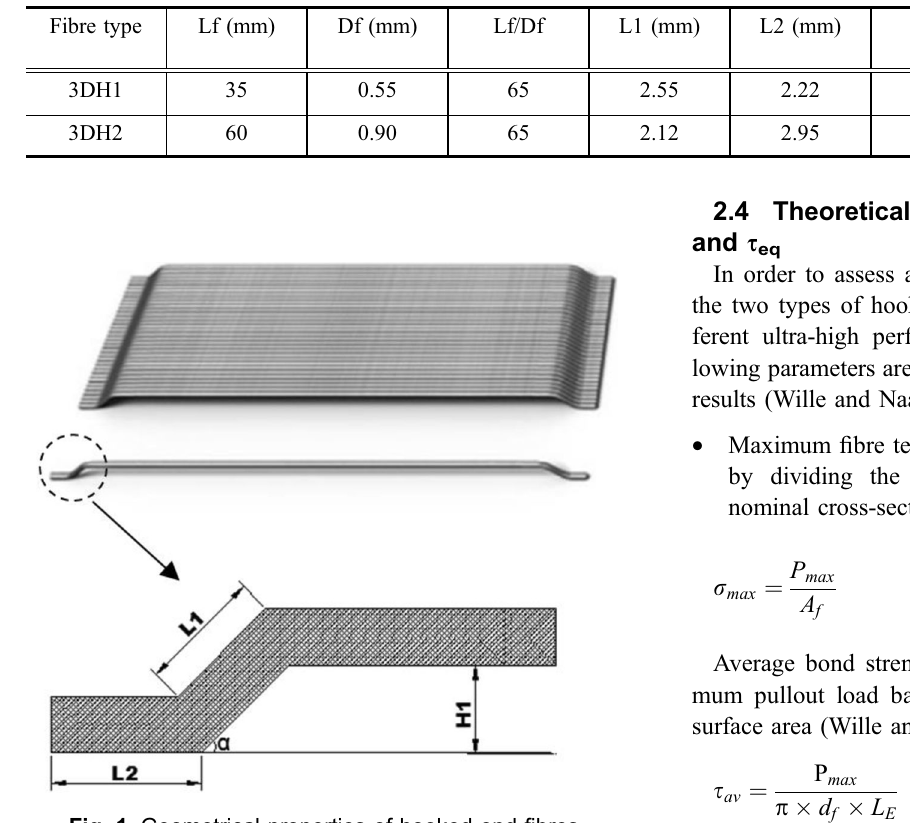
Fig. 1 Geometrical properties of hooked end fibres.